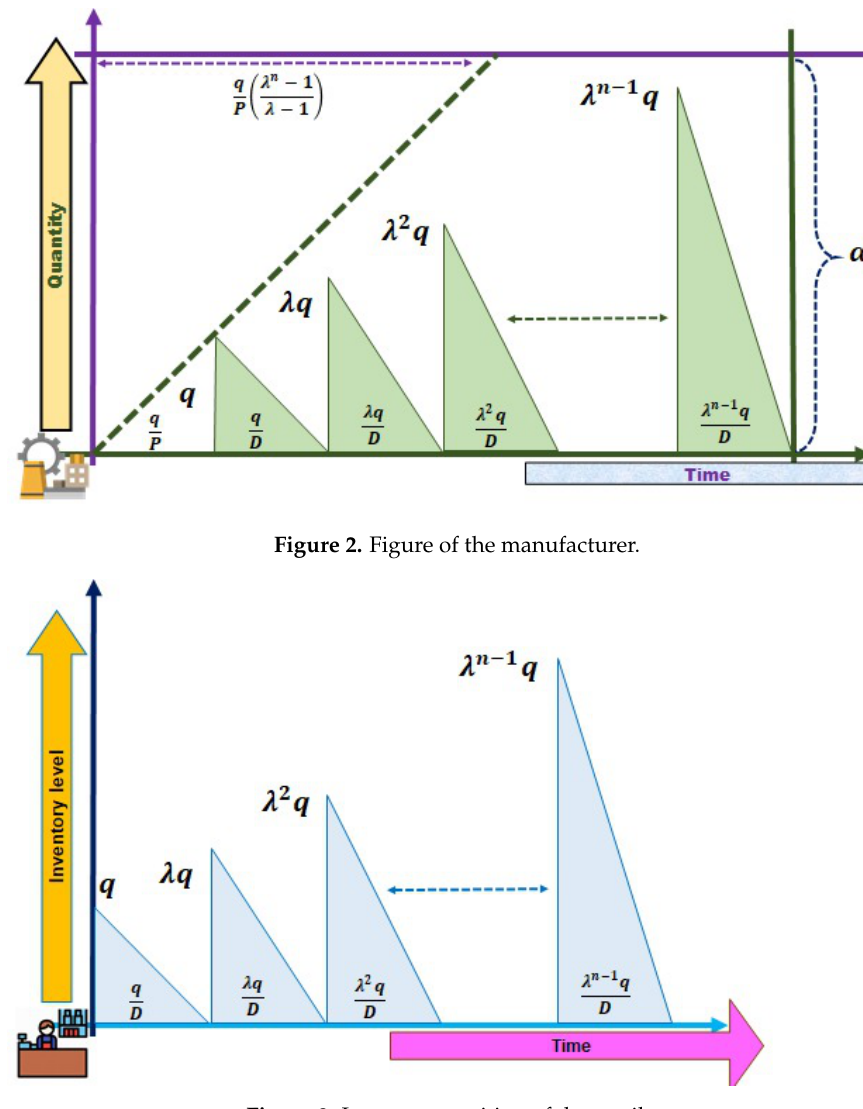
Figure 3. Inventory position of the